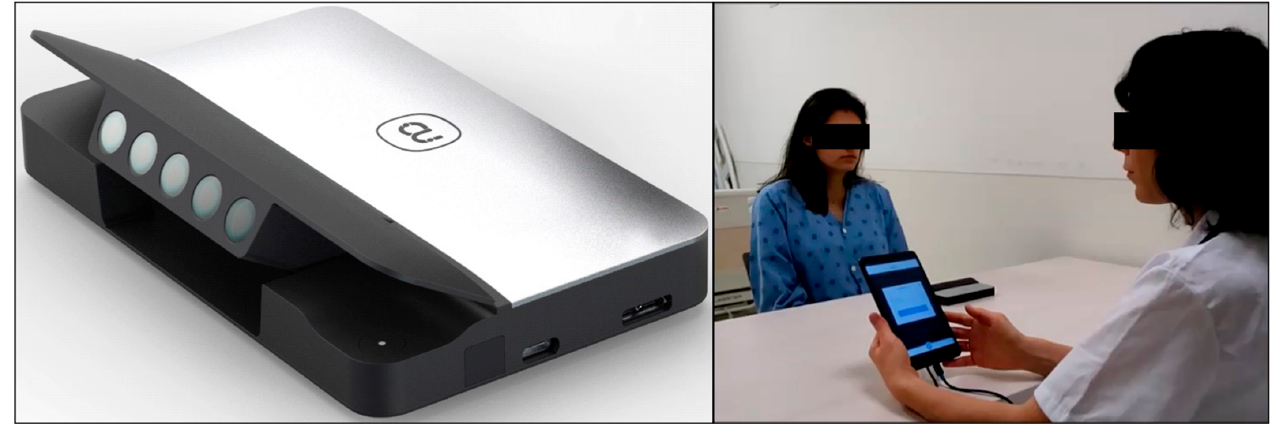
Figure 1. The “Gili” device and measurement setup.